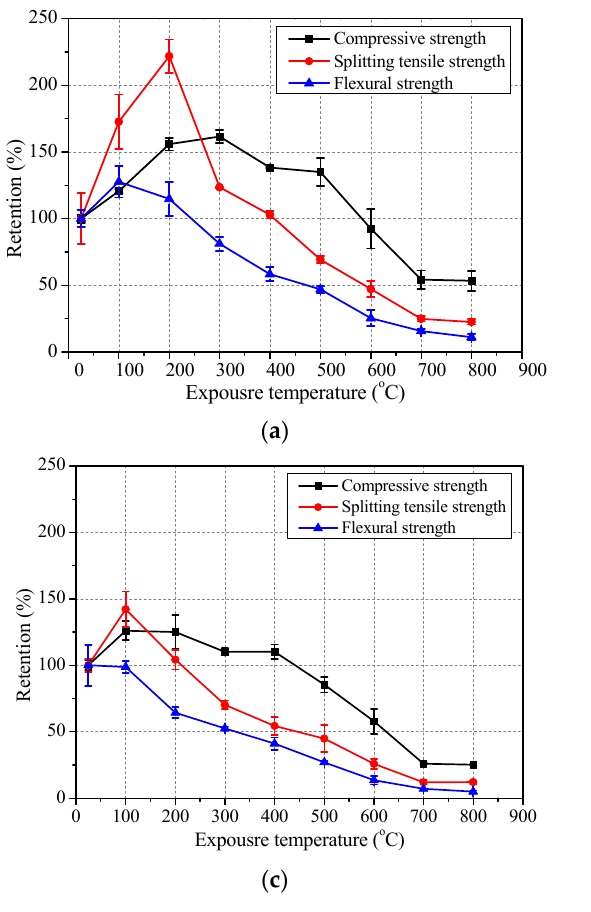
Table 5. Tested compressive strength of mortar and paste specimens.